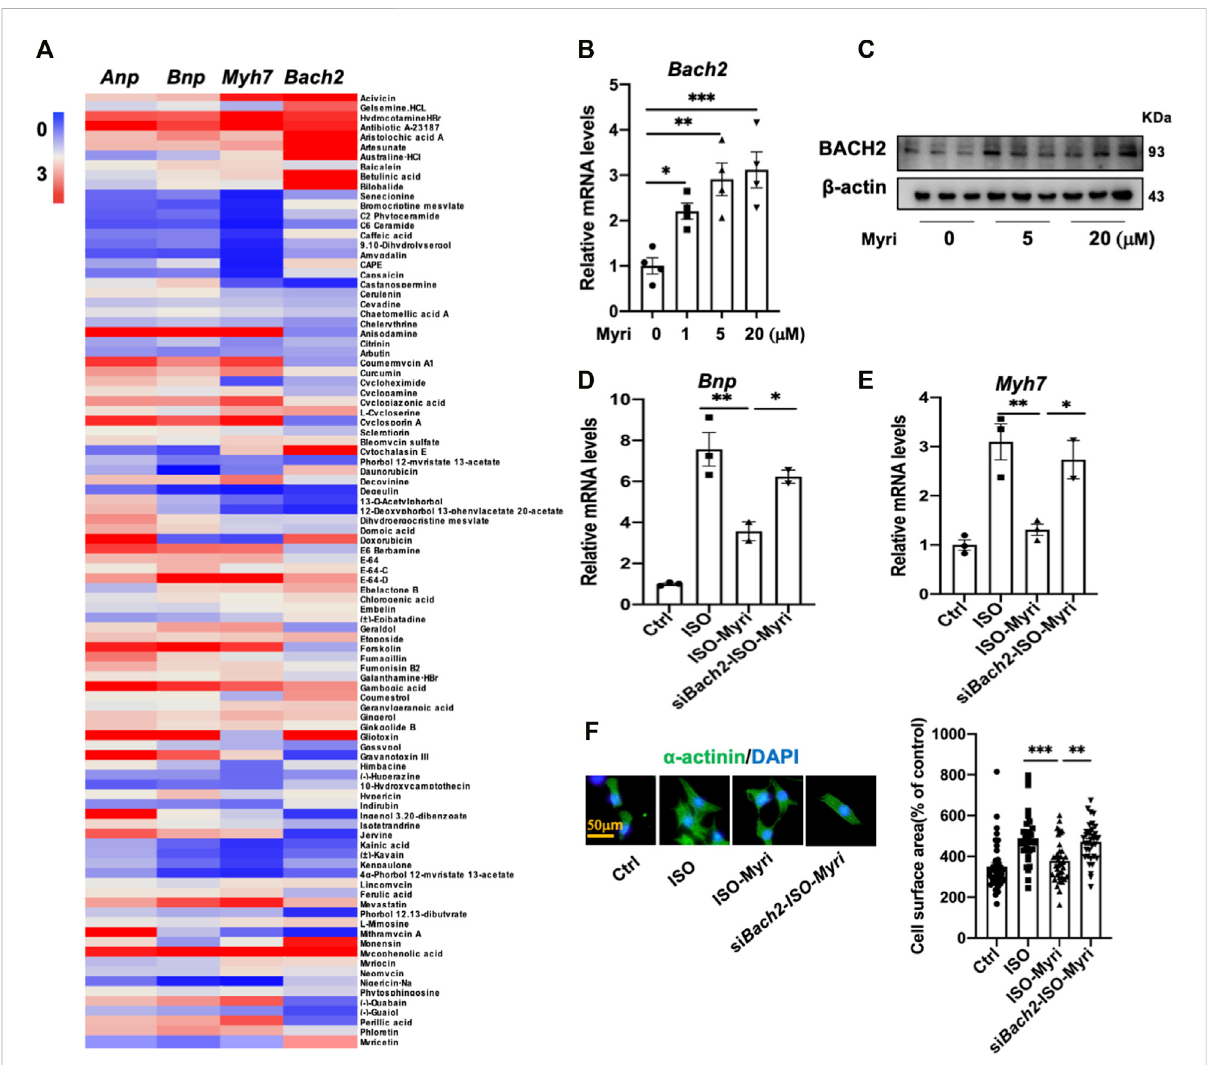
FIGURE 5 Myricetin attenuates myocyte hypertrophy partially via up-regulating BACH2 expression levels in vitro. (A) Heat map of the relative Anp, Bnp, Myh 7 and Bach2 mRNA levels in the NRVMs treated with both ISO and natural products compared to the group treated with only 10 µM ISO. (B) The Bach2 mRNA levels in indicated NRVMs (n=4). (C) Western blot showed the relative protein levels of BACH2 in the NRVMs exposed to 5 and 20 µM myricetin (n=3). (D – E) Myricetin inhibited ISO-induced increased hypertrophic gene expression levels, whereas Bach2 de fi ciency blocked this effect. (F) Representative a-actinin staining immuno fl uorescence images of NRVMs treated with 10 µM ISO and 20 µM myricetin for 24 h after transfected with siBach2 or NC and quantitative analysis of cell surface area. * P < 0.05, ** P < 0.01, *** P <